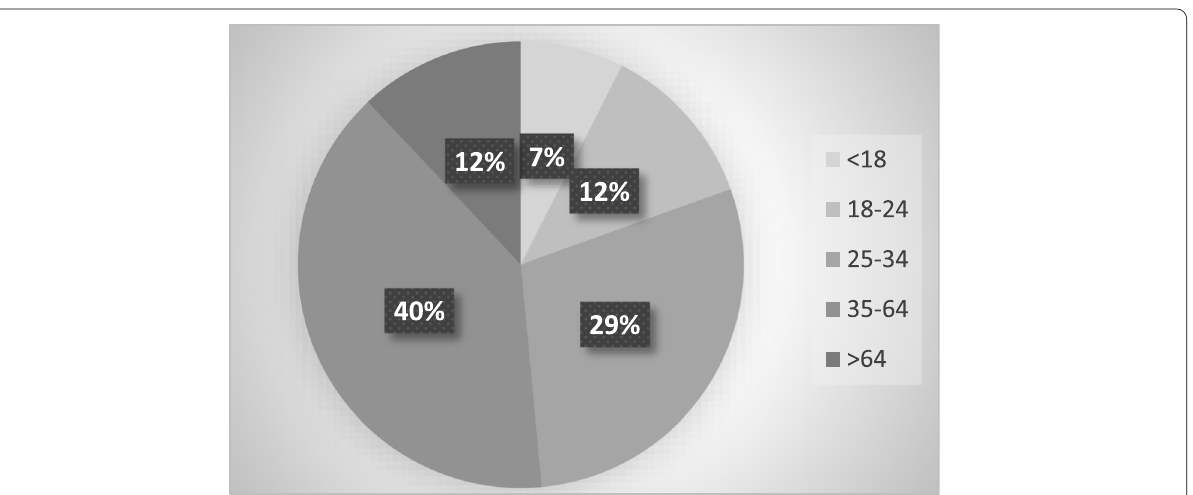
Fig. 5 Age distribution of the survey